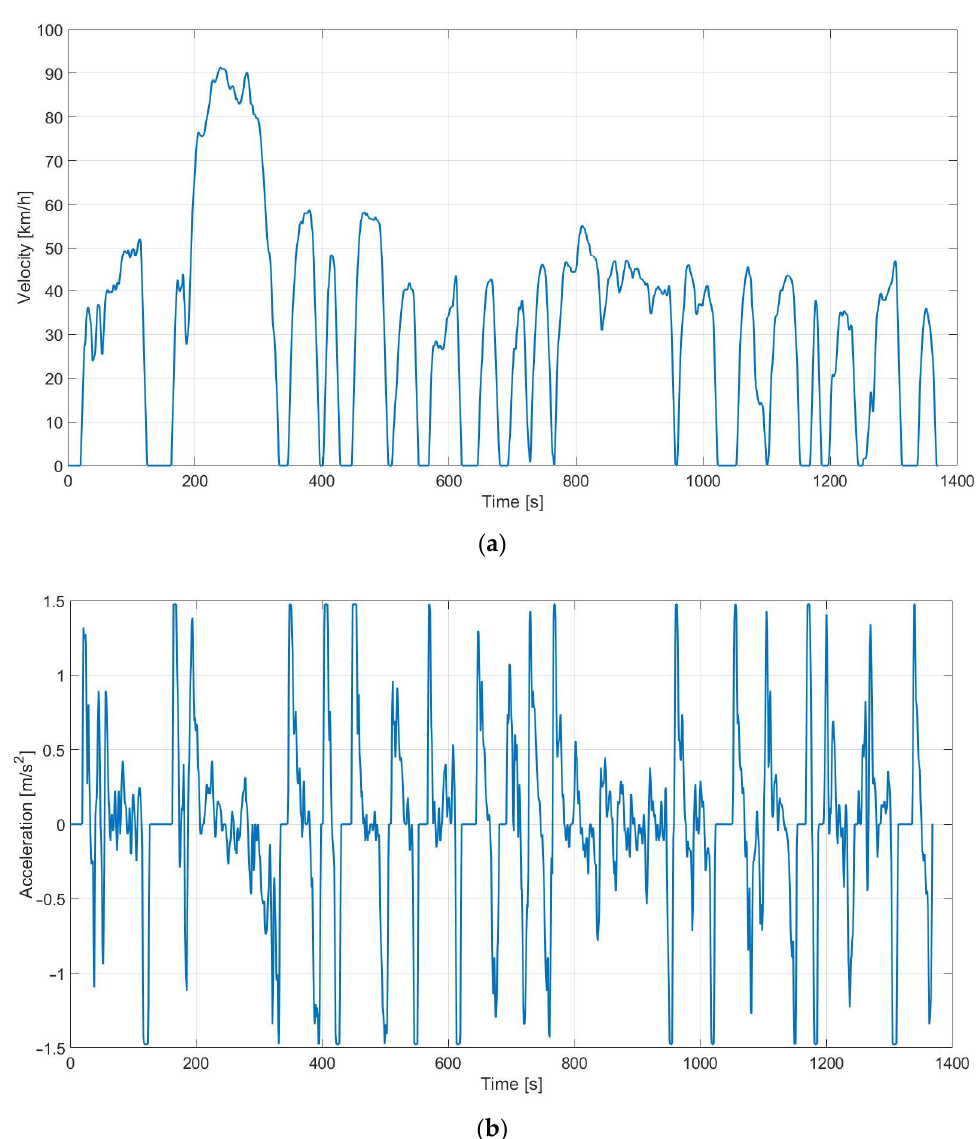
Figure 7. Drive Cycle: ( a ) Velocity Profile and ( b ) Acceleration